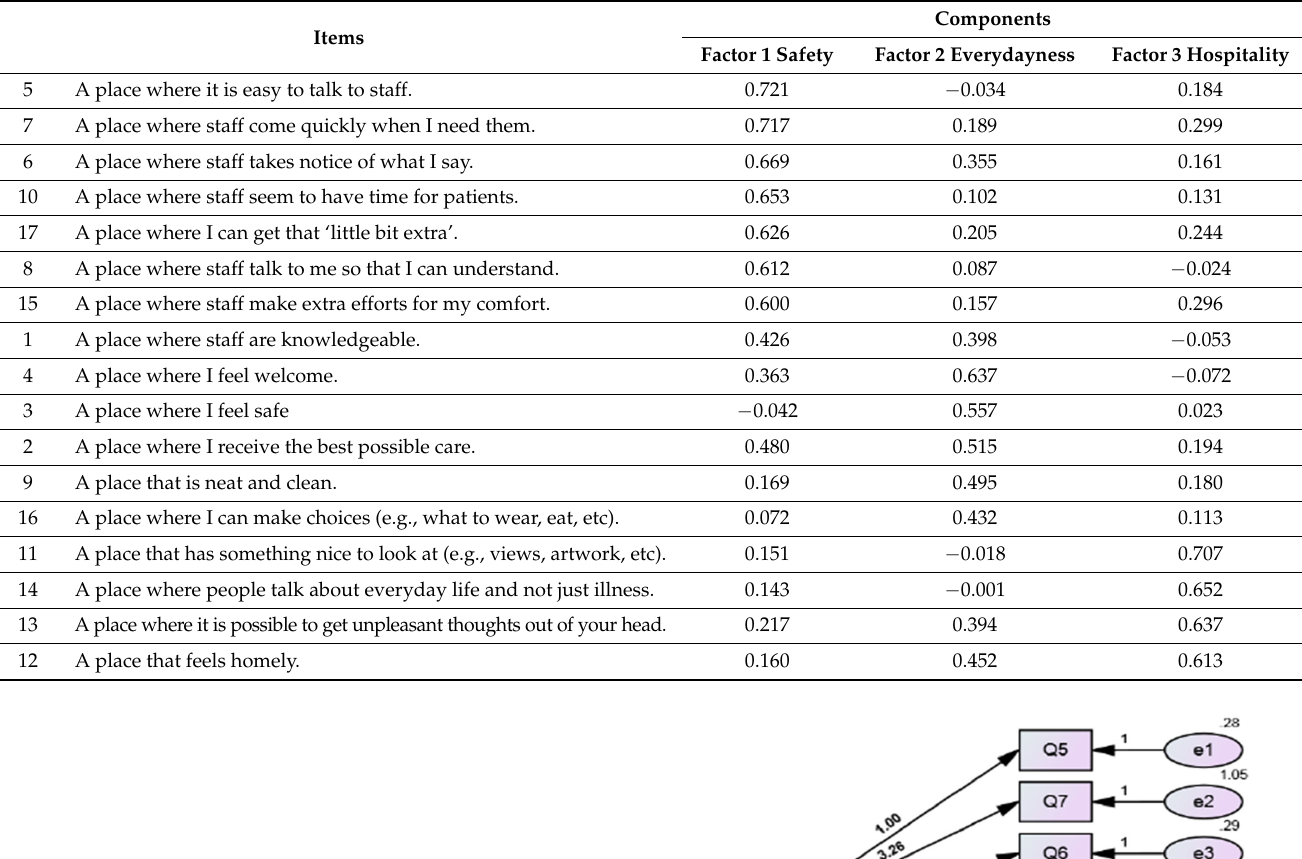
Table 4. Rotated Principal Component Matrix of PCQ-P.